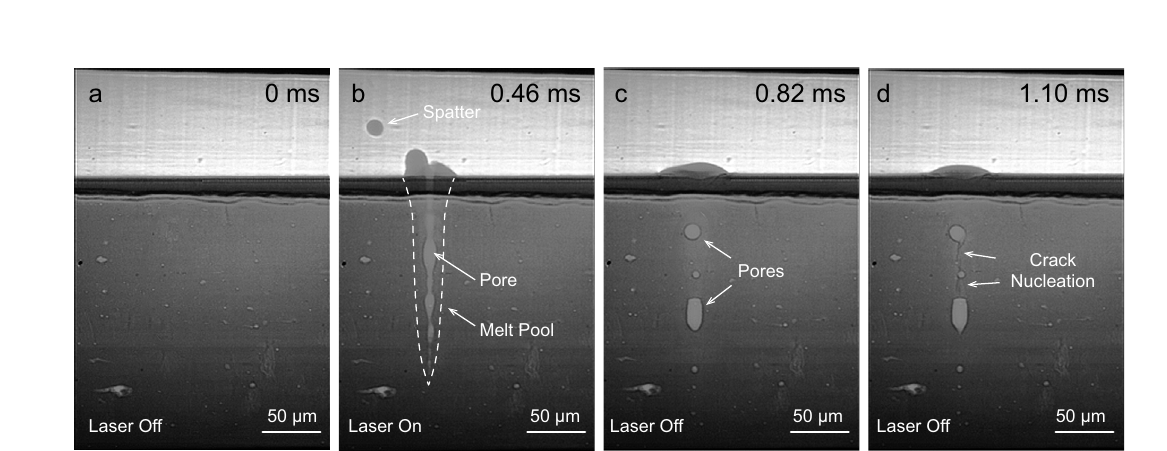
Fig. 1| Hotcracking density differenceand phaseidenti fi cationfortheas-built 0.11Si and 0.03Si samples. a , b Optical microscopy images of the as-built 0.11Si and 0.03Si samples along the build direction. c Transmission synchrotron X-ray diffraction data showing that the two samples both contain only FCC γ and MC